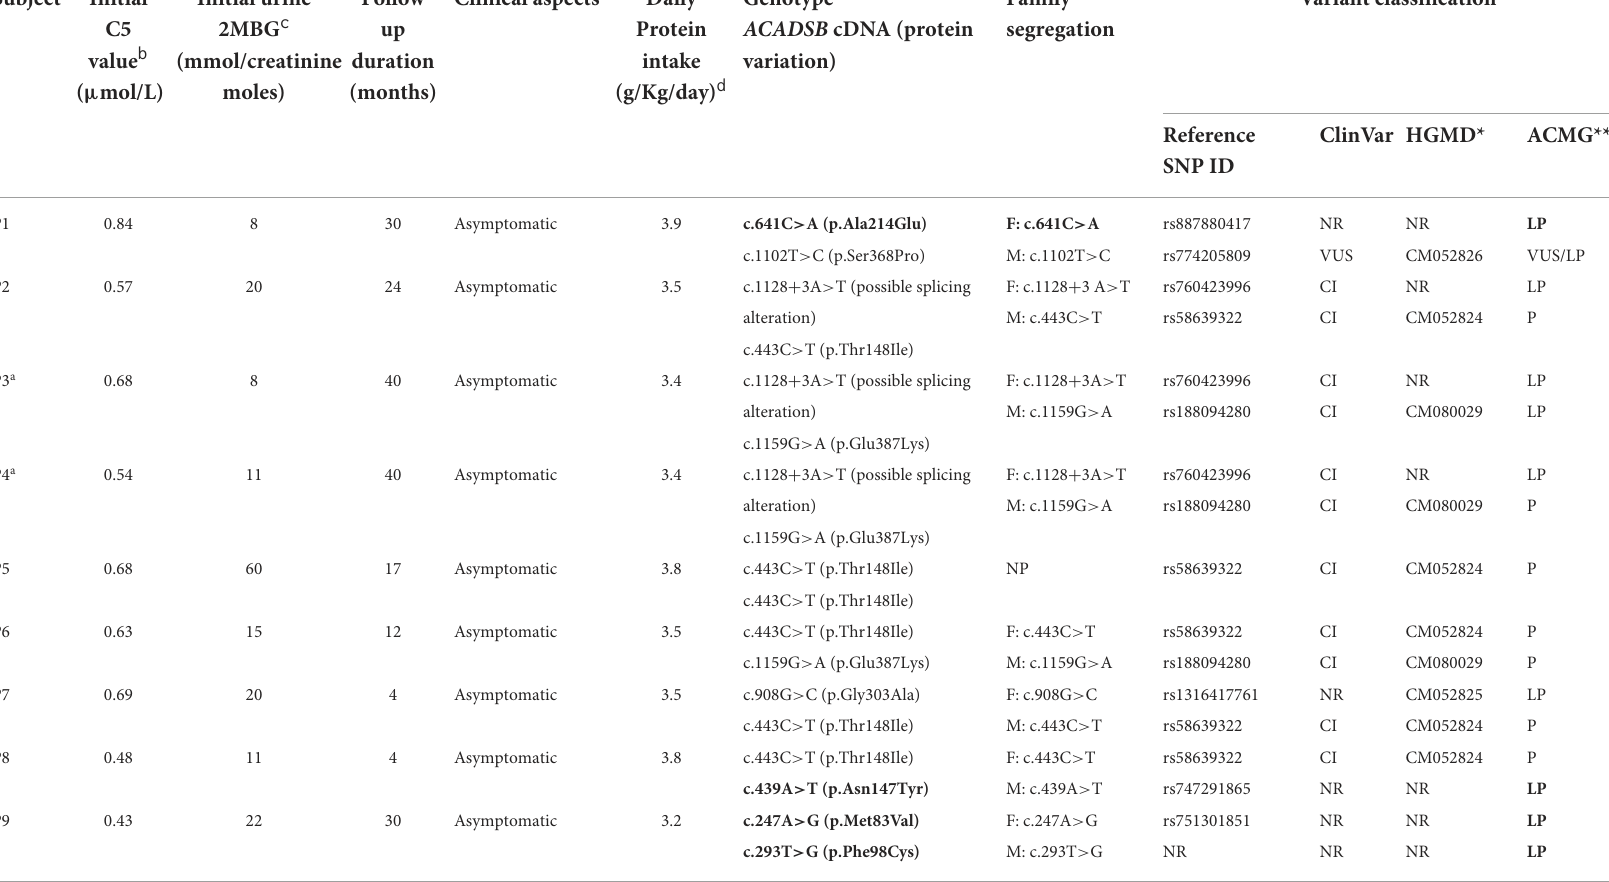
TABLE 1 Biochemical, clinical and molecular features of SBCADD